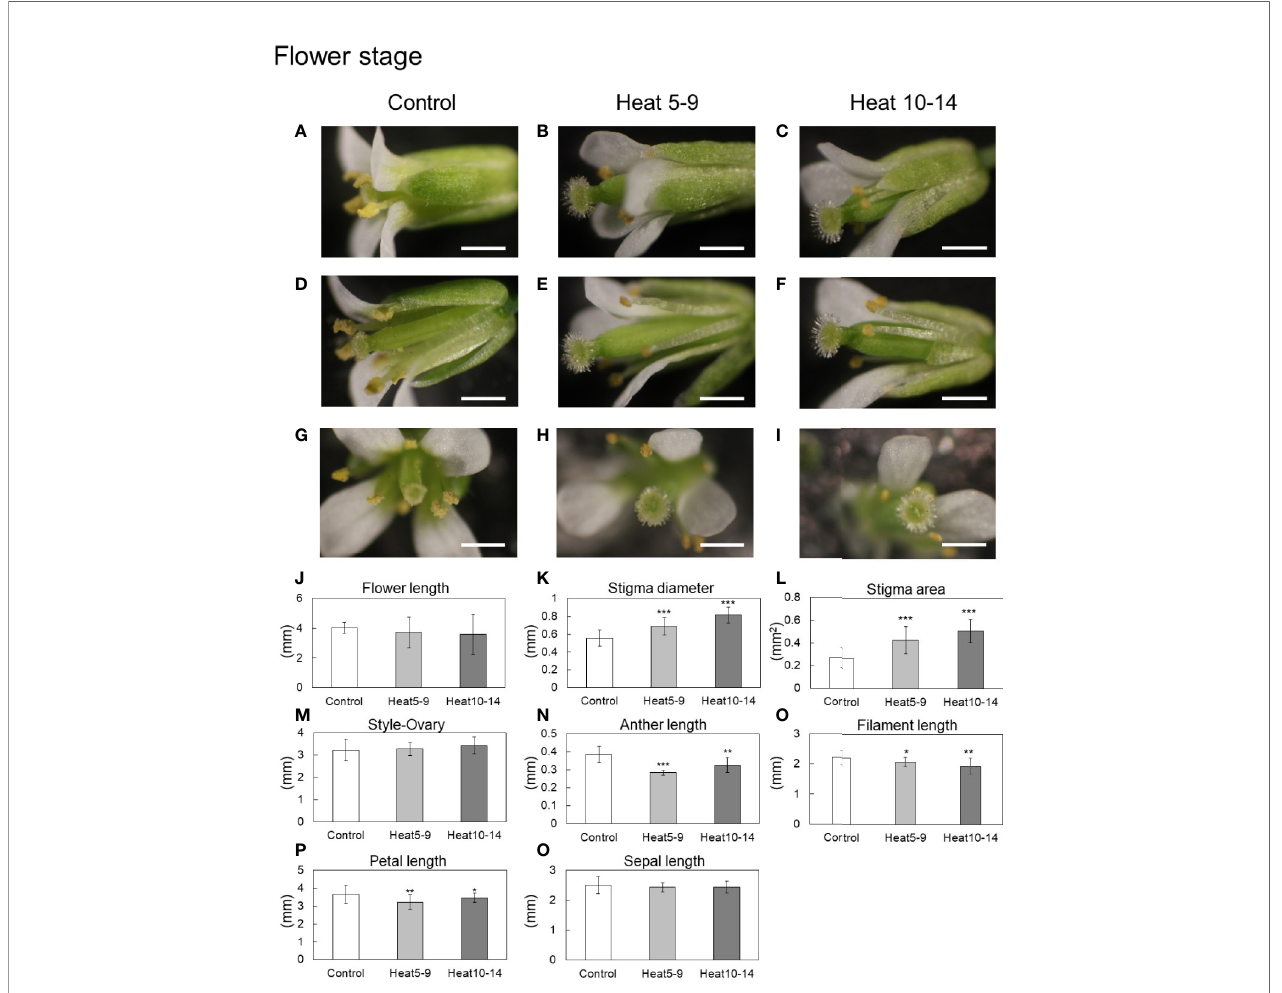
FIGURE 1 | Morphological alterations of reproductive organs in wild type plants of Arabidopsis (cv. Columbia-0) by heat stress. Plants in reproductive stage were subjected to daily heat stress for 5 – 9 days (Heat 5 – 9) or 10 – 14 days (Heat 10 – 14). (A – C) Flowers under control or heat stressed condition. (D – F) Flowers after the removal of petals and sepals for the observations. (G – I) Top view of fl owers. (J) Flower length. (K) Stigma diameter. (L) Stigma area. (M) Length between style and ovary. (N) Anther length. (O) Filament length. (P) Petal length. (Q) Sepal length. White bars in pictures indicate 1 mm. Bars in graphs indicate standard error. *, ** and ***: Student t -test signi fi cant at p < 0.05, p < 0.01 and p < 0.005, respectively compared to control (n=6 –